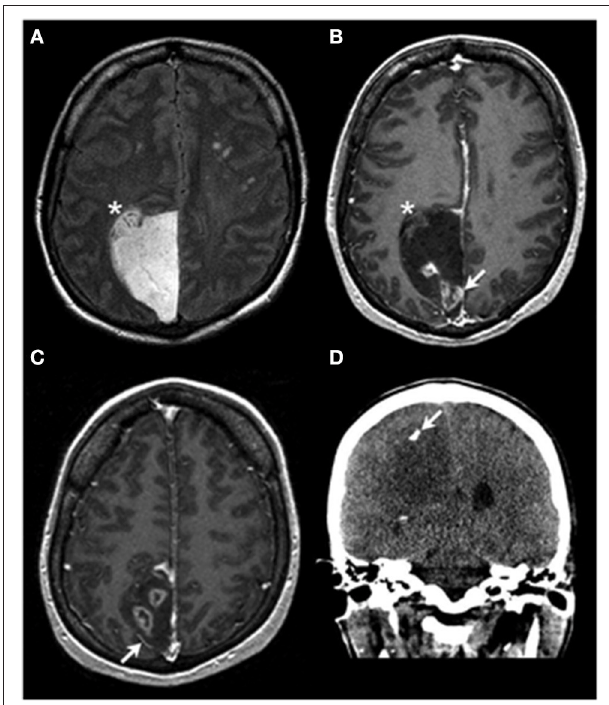
FIGURE 1 | Radiologic findings. Axial T2-weighted FLAIR imaging (A) demonstrates an extra-axial hyperintense mass centered within the right paramedian parietal region with a focus that appears to be inseparable from the adjacent cortex (asterisk in A,B ). On the axial T1 post contrast images (B,C) the lesion is predominantly nonenhancing and hypointense, with areas of heterogeneous enhancement (arrow in B ). Also noted is lateral displacement of a cortical vessel (arrow in C ), suggestive of an extra-axial location of the mass. Coronal non-contrast CT imaging demonstrates a focus of coarse calcification (arrow in D ) in the hypoattenuating